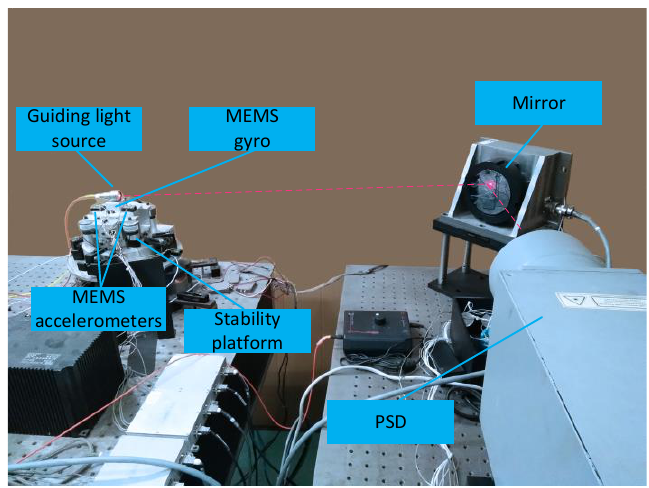
Figure 7. The optical tracking experiment platform.